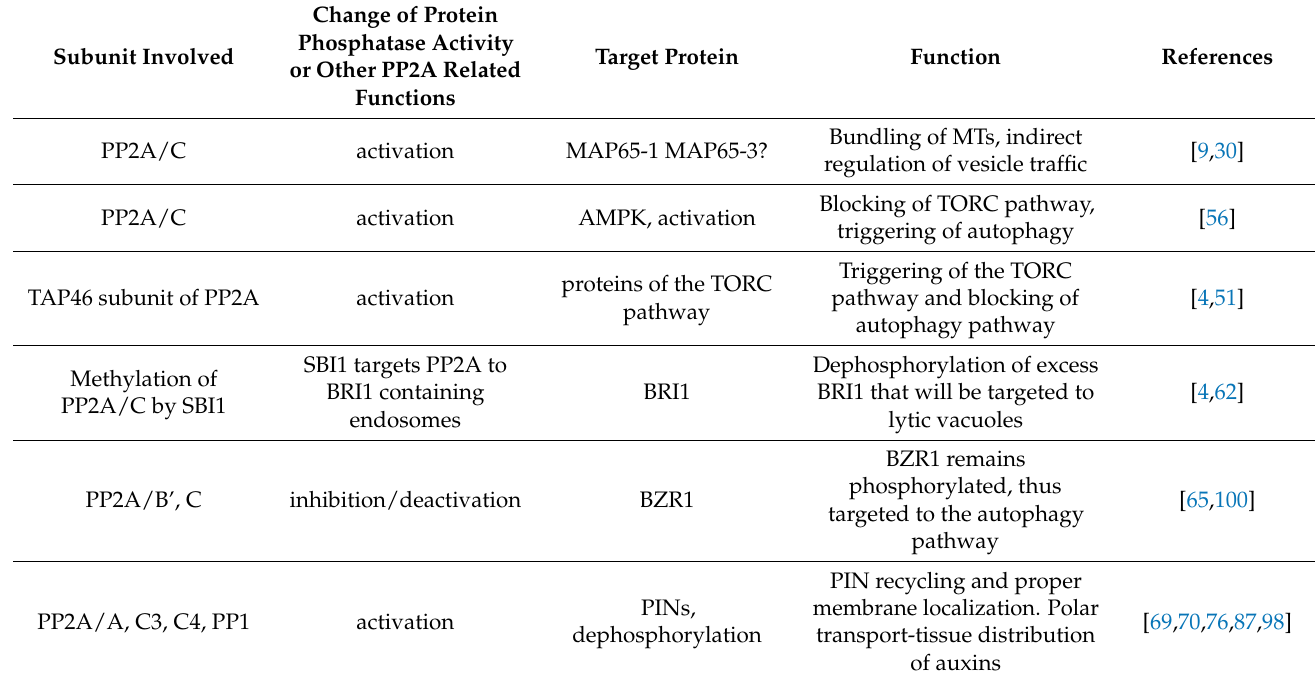
Table 1. Examples for the involvement of PP2A (PP1) in vesicle traffic of plant cells. See text for more